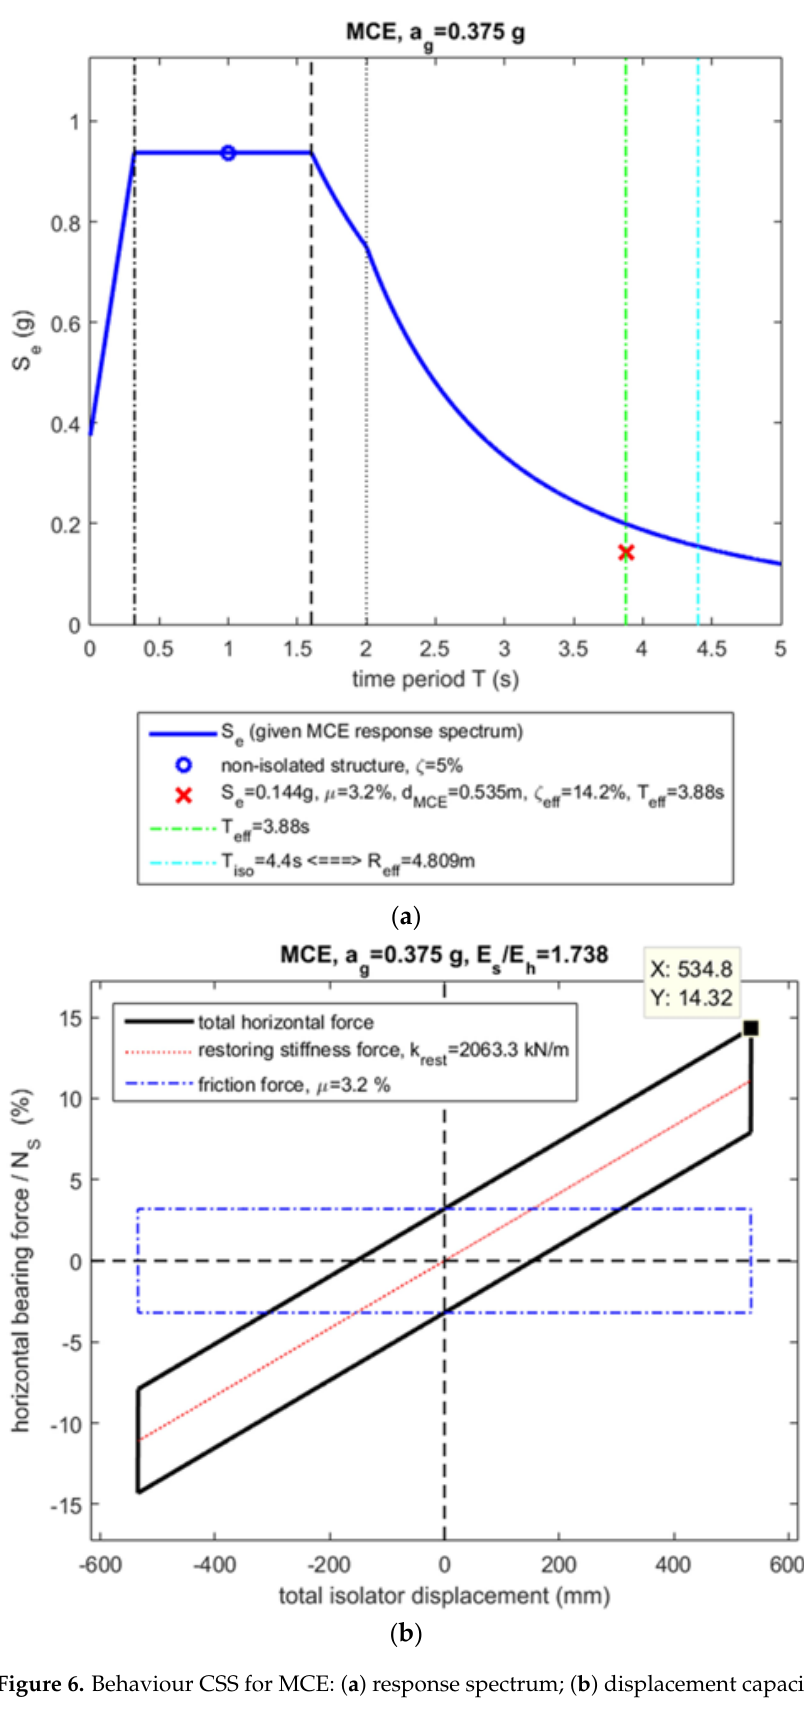
Figure 6. Behaviour CSS for MCE: ( a ) response spectrum; ( b ) displacement capacity.